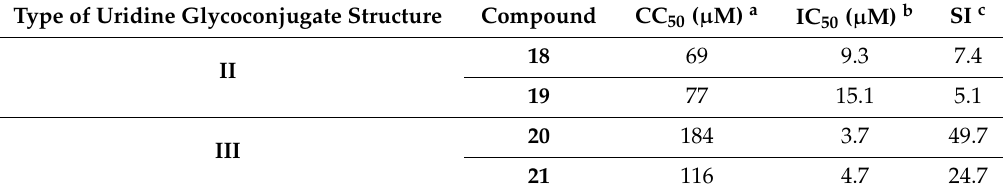
Table 1. Antiviral activity of uridine glycoconjugates 18–21 against TBEV Neudoerfl strain. Type of uridine